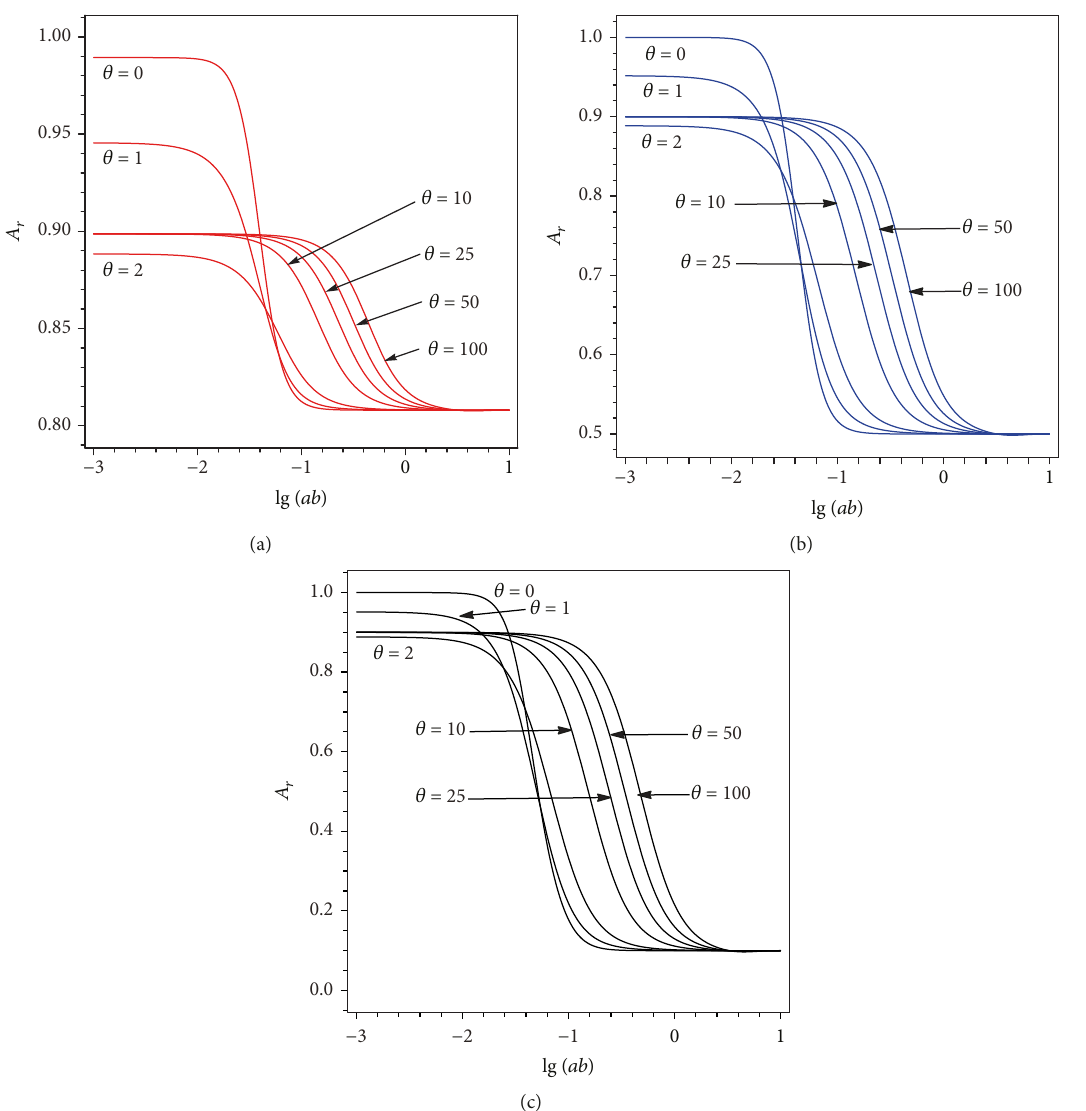
Figure 2: Changes of the amplitude ratio A equal to (a) 0.8, (b) 0.5, and (c) 0.1. The loading coe ffi cient L